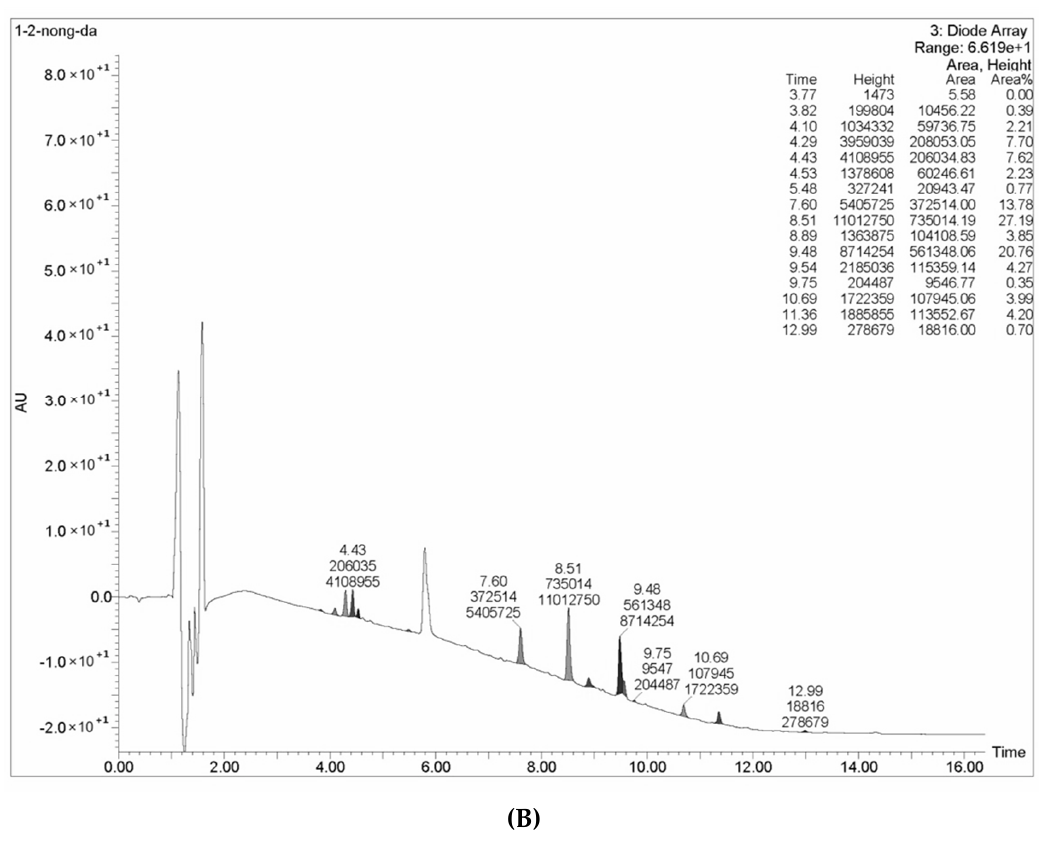
Figure 7. The HPLC chromatogram of methyl red after decolorization by Lepista nuda laccase. ( A ) Methyl red control group ( B ) Methyl red which had been subjected to decolorization by the laccase for 48 h.